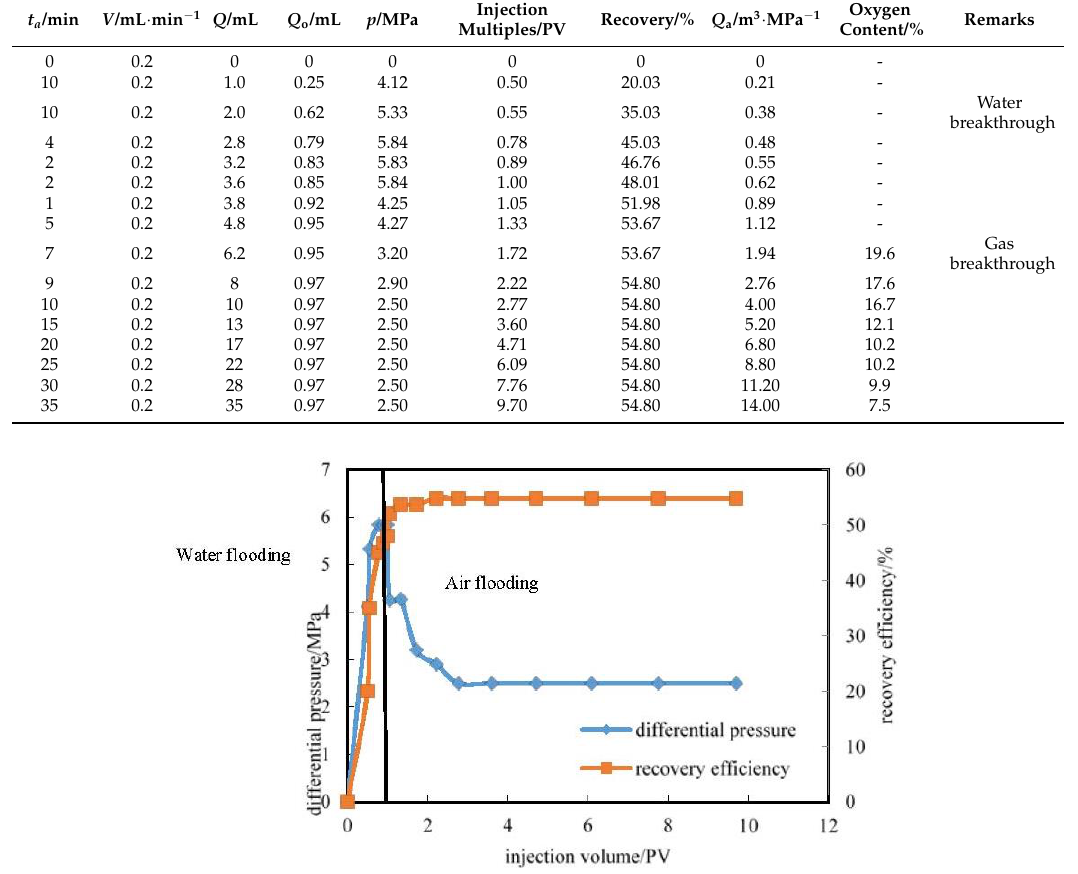
Figure 6. Pressure differential, recovery ratio relationship of multiple injections.